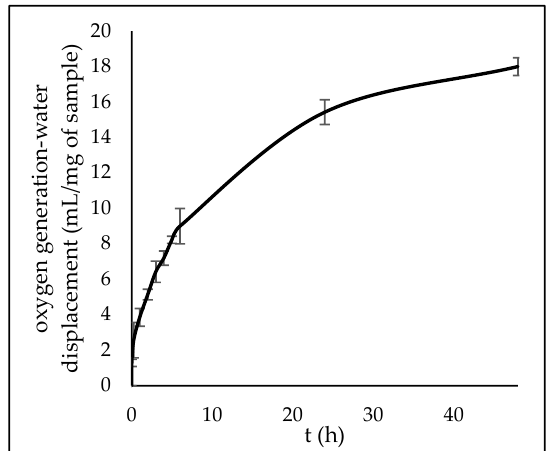
Figure 6. Oxygen generation from P1:PLA1:O 2 , measured for 2 days.